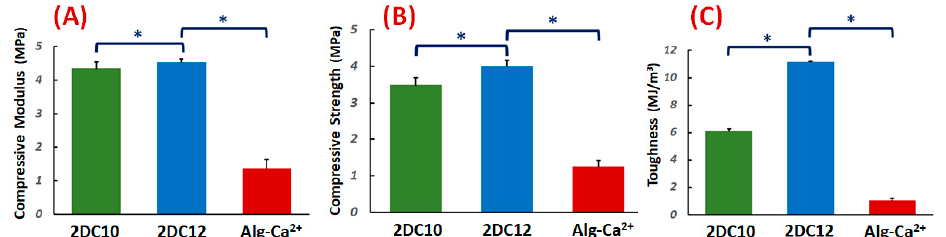
Figure 2. Mechanical properties of nanohybrid Alg-CD + Ad-GO hydrogels: ( A ) compressive modulus (at 80% strain), ( B ) compressive strength and ( C ) toughness of DC hydrogels (*: p < 0.05).